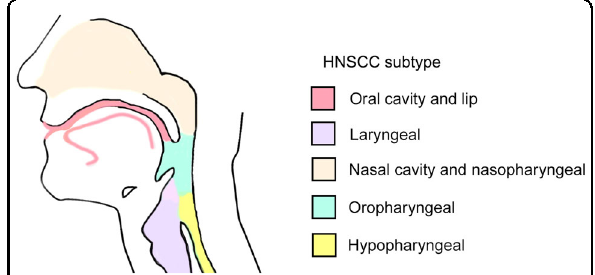
Fig. 1 HNSCC subtypes according to anatomical location. Oral cavity cancer is found in the buccal mucosa, oral tongue, alveolar ridge, fl oor of the mouth, hard palate, and retromolar trigone. Laryngeal cancer is found in the supraglottis, vocal cords, glottis, and subglottis. Oropharyngeal cancer is found in the soft palate, base of the tongue, tonsillar pillars, and tonsillar